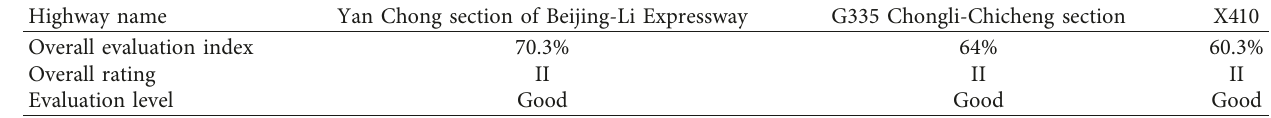
Table 14: Three highway comprehensive evaluation